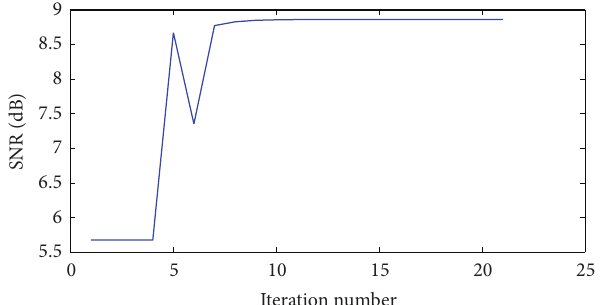
Figure 5: Example SNR versus iteration number for the SNR steepest ascent method. Overshoot is detected at iteration 6, at which point the value of 𝜇 is decreased to minimise the likelihood of the algorithm overshooting again.